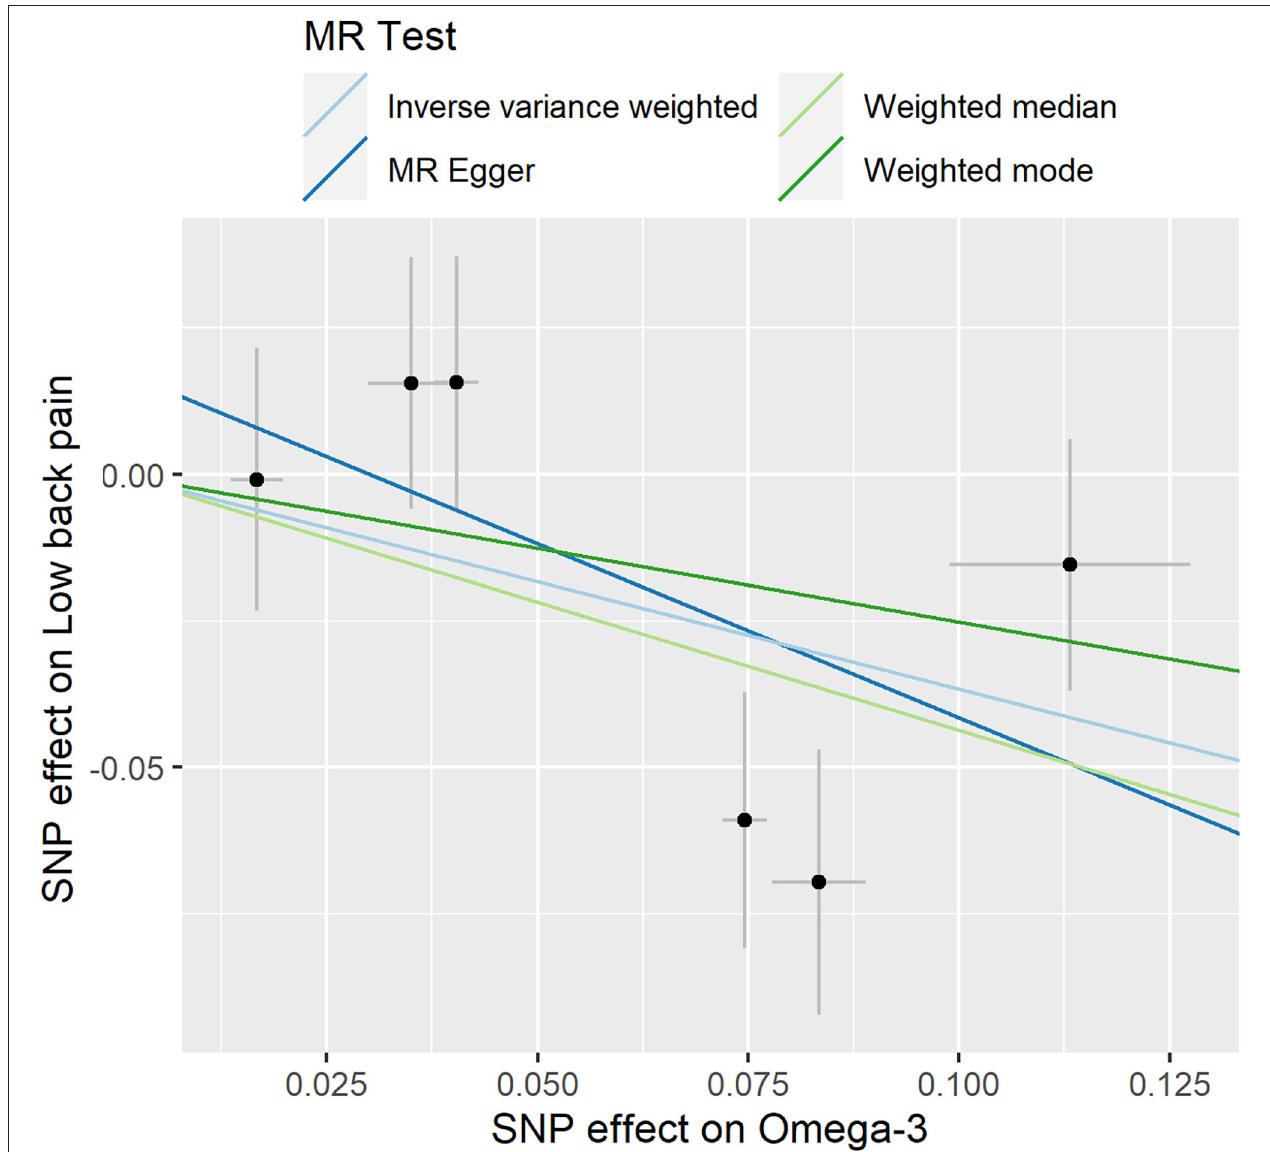
FIGURE 2 | Individual estimates about the putative causal effect of omega-3 on low back pain. The x-axis shows the single nucleotide polymorphism (SNP) effect and SE on each omega-3. The y-axis shows the SNP effect and SE on low back pain. The regression line for MR Egger, Weighted median, inverse variance weighted (IVW), Simple mode, and Weighted mode is